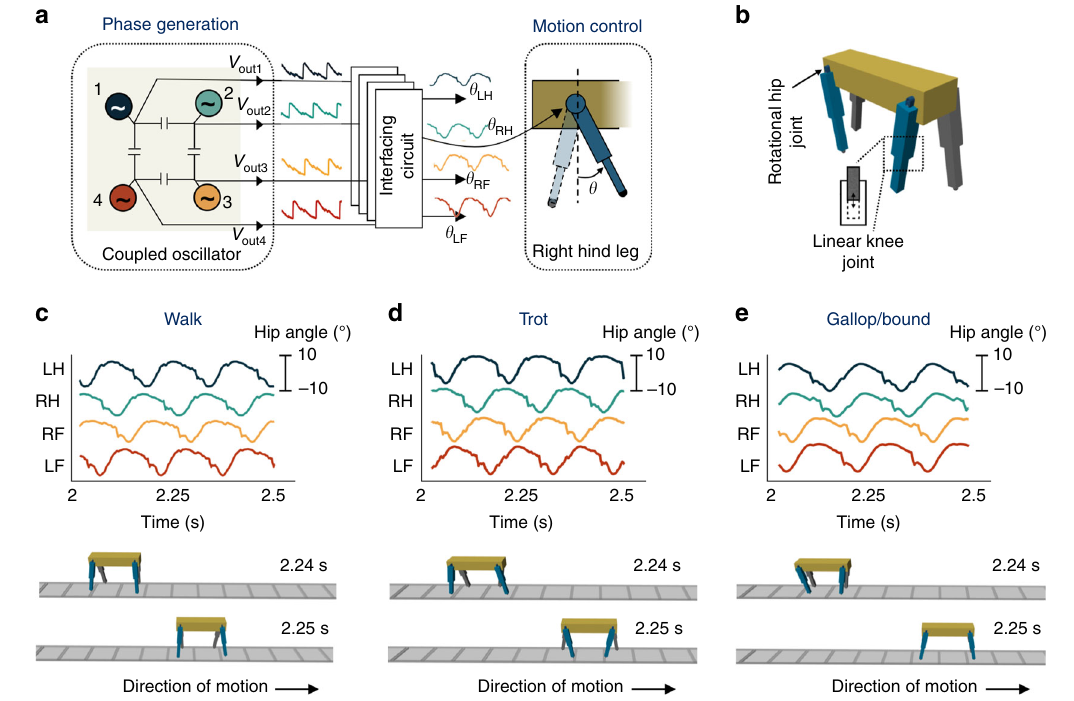
Fig. 5 Robotic simulation illustrating insulator-to-metal phase-transition (IMT) oscillator-based central pattern generator (CPG) hardware for real-time quadruped locomotion. The simulation setup is shown in a , b . The experimentally measured voltage outputs v i ( t ) from the oscillator network are transformed into rotational hip joint angles of the quadruped using a simple transformation θ depending on the target angle waveform. c – e Temporal evolution of the hip angles of the quadruped obtained from the IMT oscillator-based CPG for the three different gaits and the snapshots of locomotion obtained from the robotic